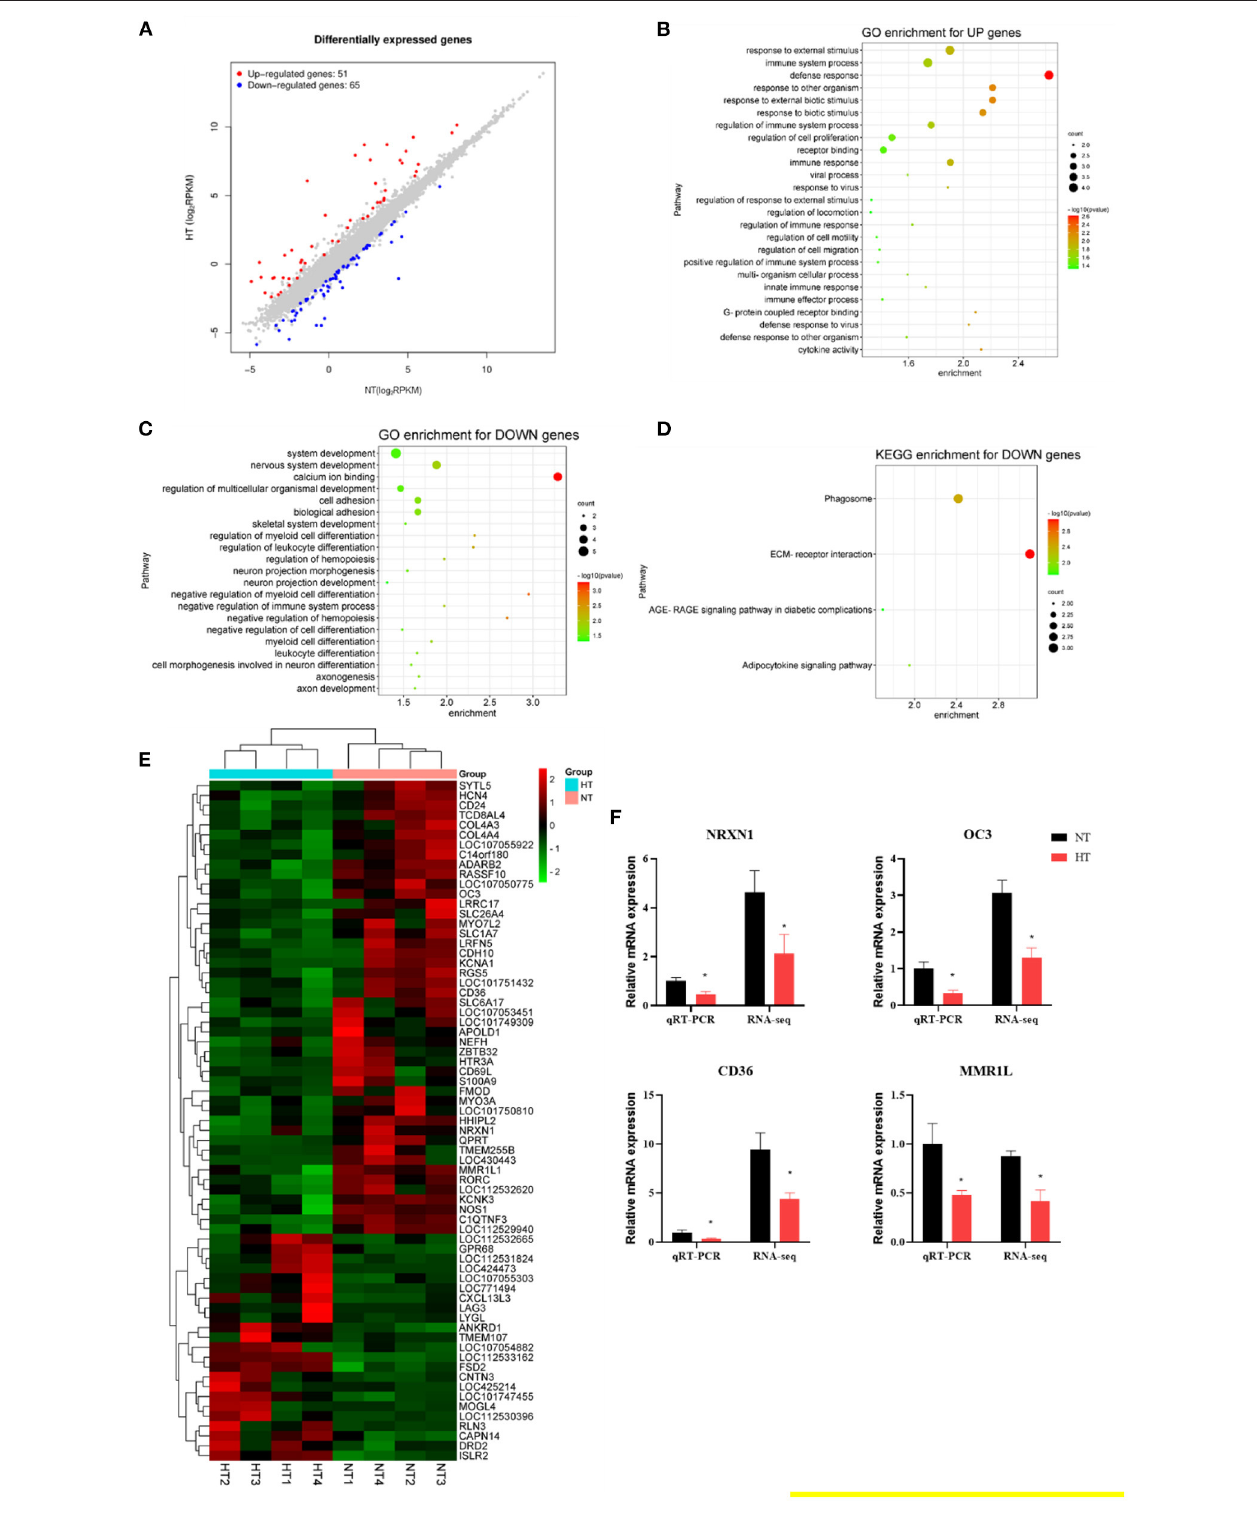
FIGURE 4 | Effects of heat stress on the splenic transcriptome of 42-day-old broilers (d 14 of heat treatment). (A) Numbers of heat stress-induced differentially expressed splenic genes ( P < 0.05 and fold change ≥ 2; n = 4). (B) GO terms enrichment of splenic gene expression for up genes in broilers ( P < 0.05). (C) GO terms enrichment of splenic gene expression for down genes in broilers ( P < 0.05). (D) KEGG terms enrichment of splenic gene expression for down genes in broilers ( P < 0.05). (E) The heat map of DEG genes in broilers. (F) Validation of the gene expression profile by real-time PCR. Asterisk means significant difference with NT group (* P < 0.05). RSV, resveratrol; NT, normal temperature; HT, heat stress.